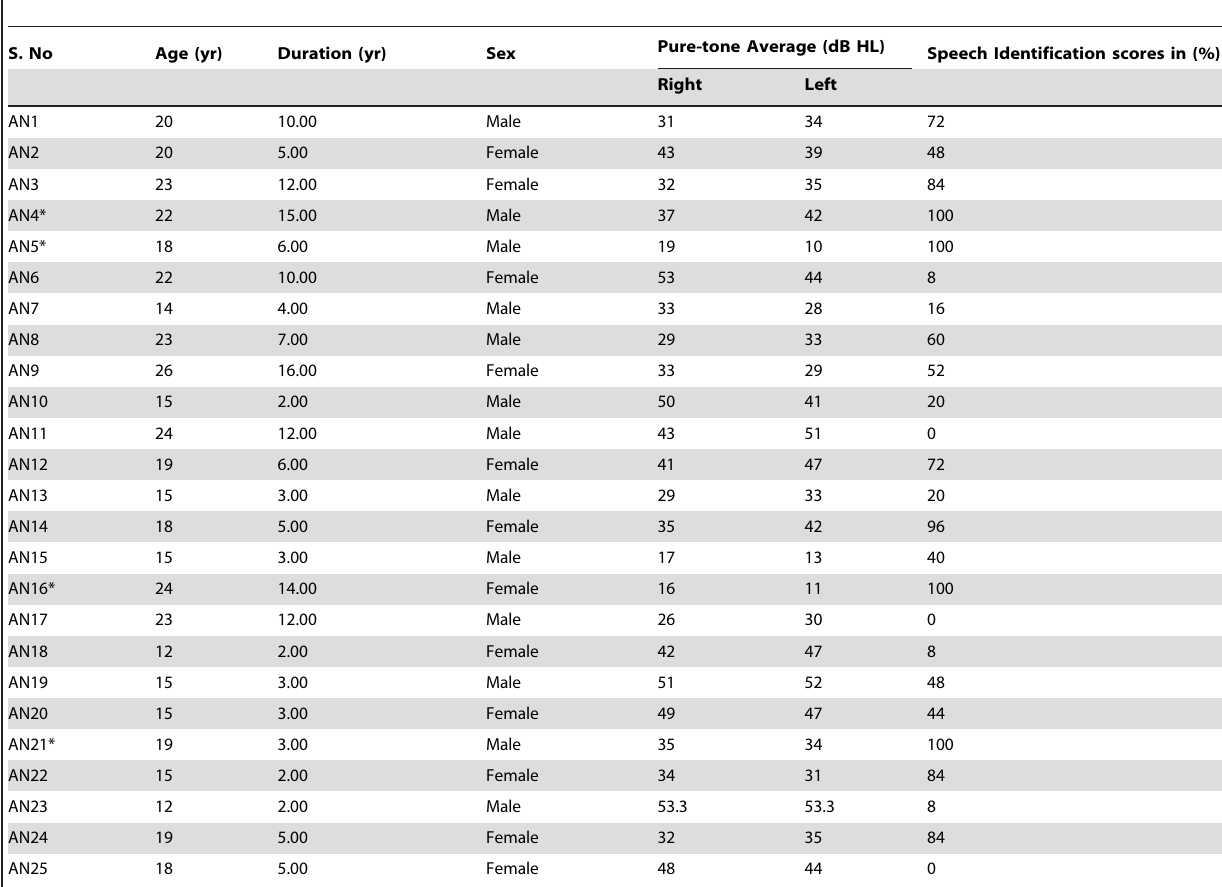
Table 1. Audiological profile of participants with auditory